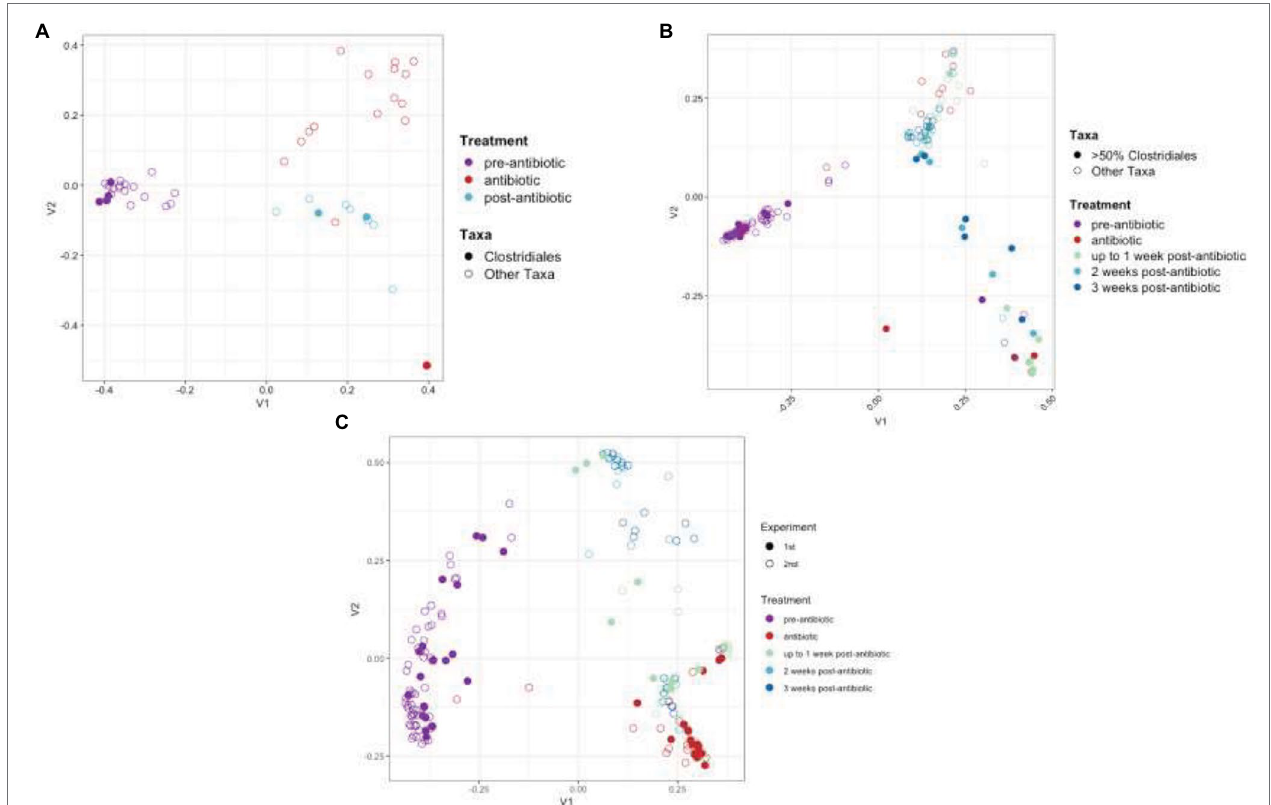
FIGURE 2 | Principal coordinate analysis (PCoA) of taxonomic profiles. PCoA analysis based on the Bray-Curtis distance matrix of OTUs from TZP1 (A) and TZP2 (B) experiments. Each circle represents a single mouse at a single time point. Closed circles represent mice that had >50% Clostridiales (OTU-1 in A , OTU-3 in B ) at any time point and open circles represent all other mice. (C) PCoA analysis on Bray-Curtis distance matrix based on combined genera profiles from both experiments. Note that the number of bullets per panel may vary as a consequence of the number of mice per group and the number of samples taken and analyzed in full per individual